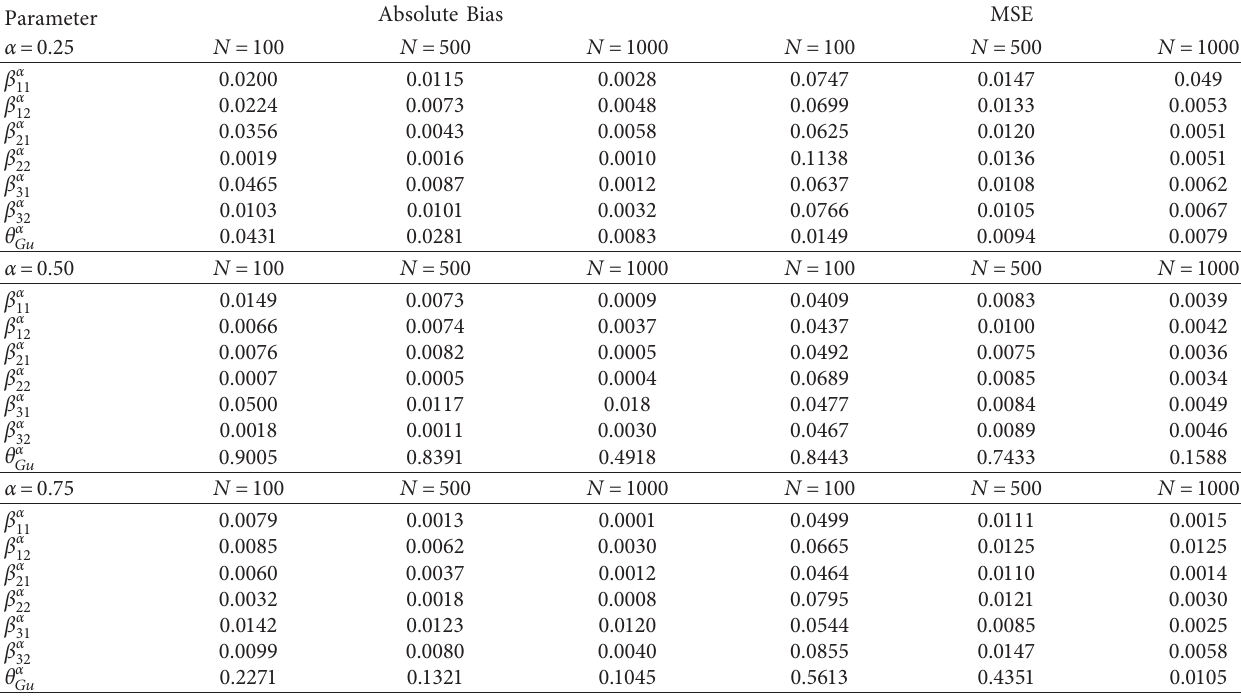
Table 4: Absolute Bias and MSE of parameter estimates from the Bayesian estimation of the Gumbel copula with different sample sizes. Parameter Absolute Bias MSE α �